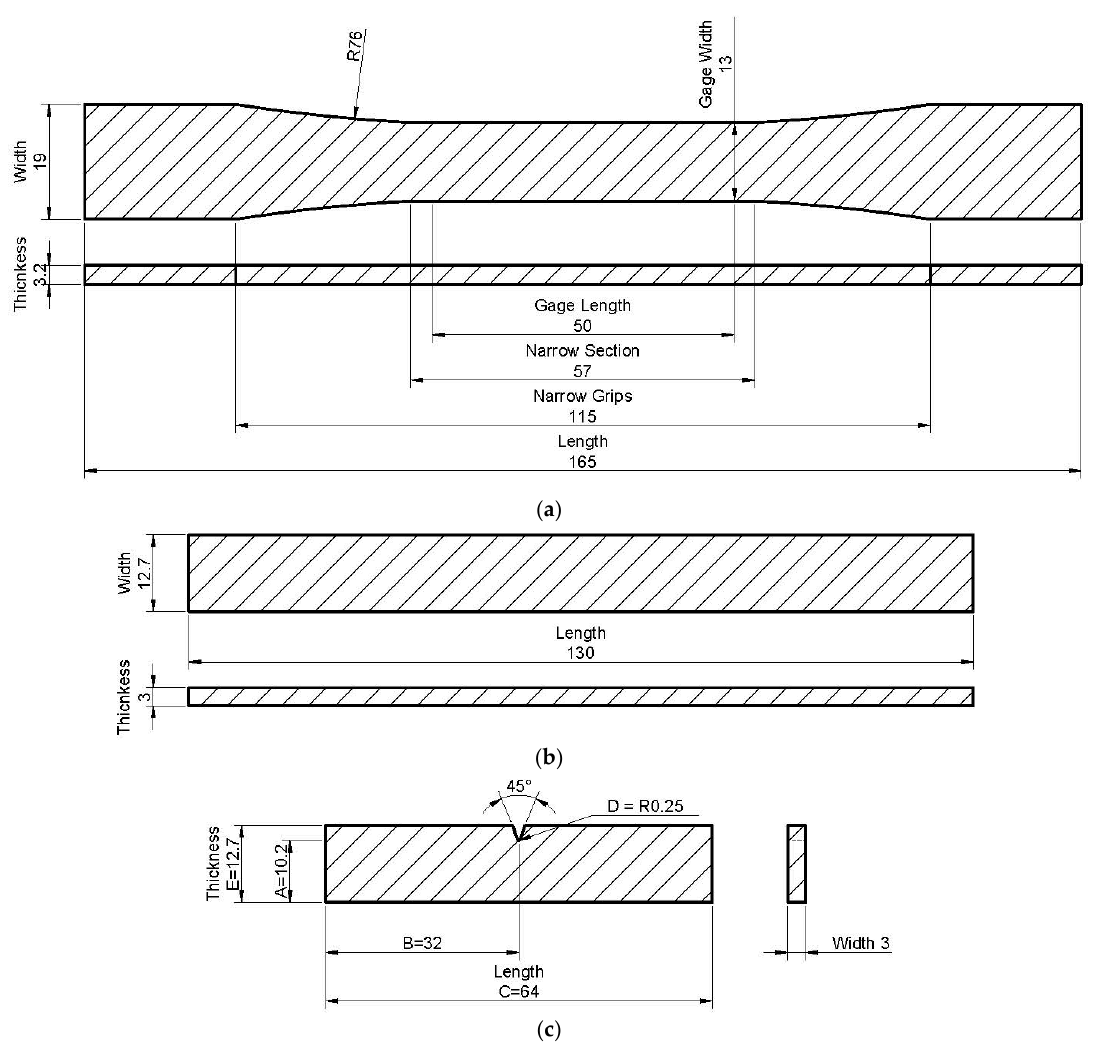
Figure 2. Dimension of specimens [mm] for ( a ) tensile; ( b ) bending; ( c ) impact test.